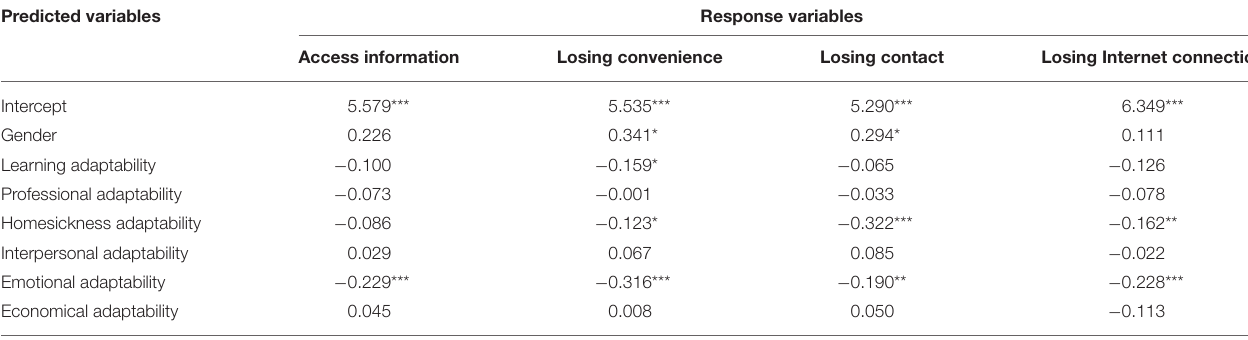
TABLE 2 | Traditional multiple regression model about nomophobia and adaptability.